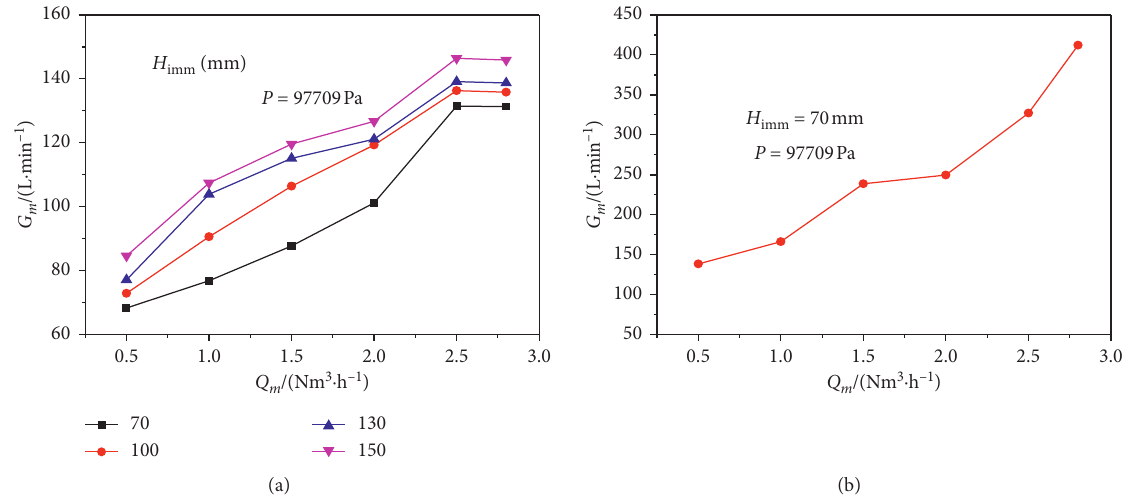
Figure 6: Variation of circulation flow rate G m as a function of gas flow rate Q m . (a) RH with circular snorkels. (b) RH with arched snorkels.